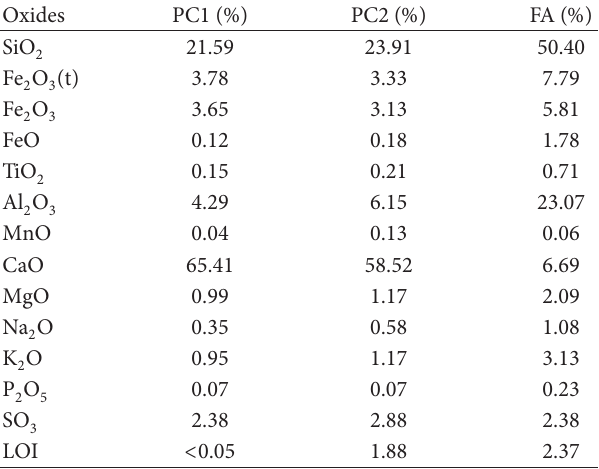
T 1: Chemical composition of initial materials.